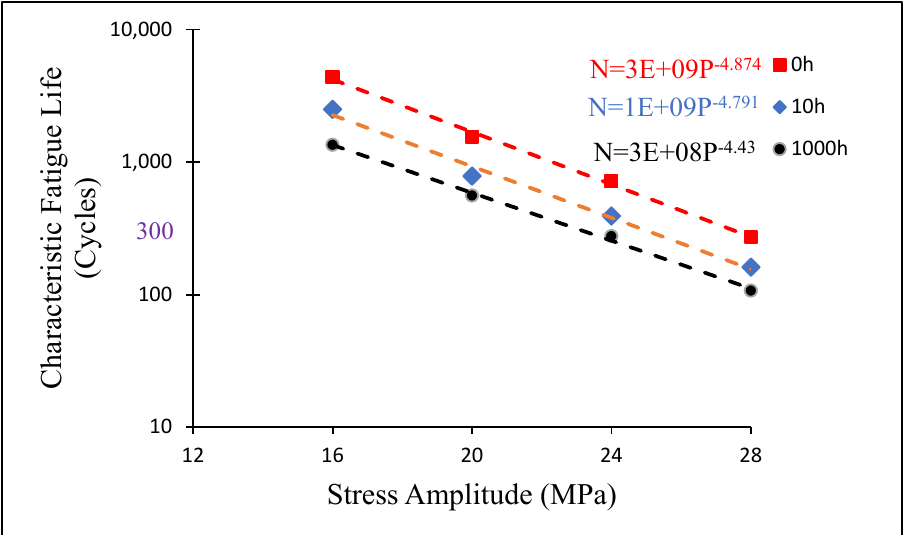
Figure 6. Fitted power equation of characteristic fatigue life (cycles) versus stress amplitude for non-aged, 10 h and 1000 h aged SAC305.